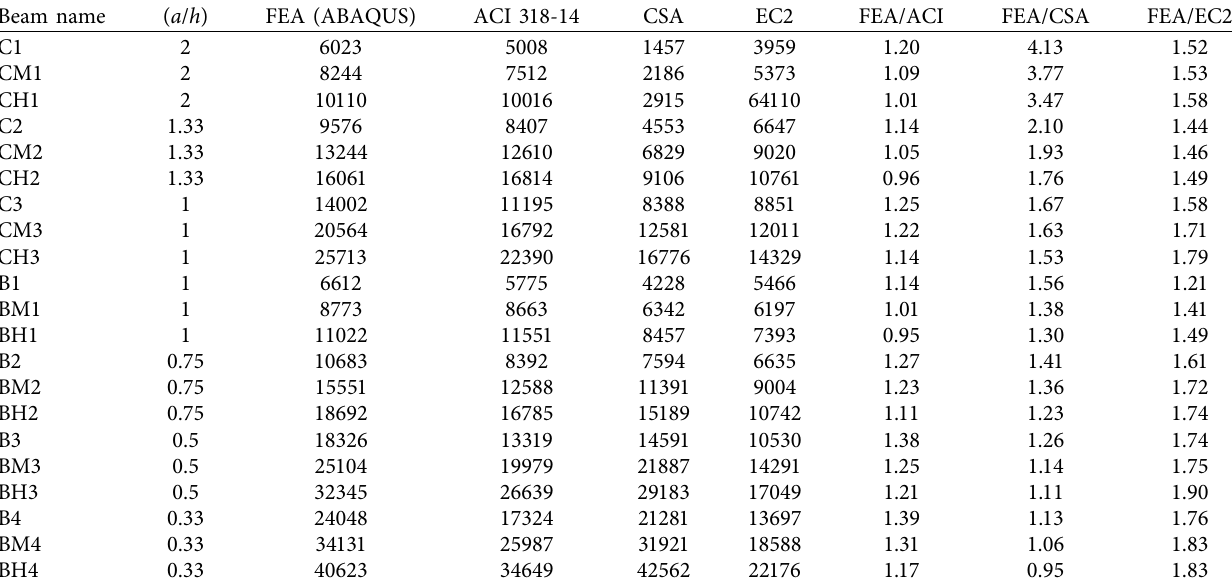
Table 7: Comparison of the numerical analysis result and STM of different design